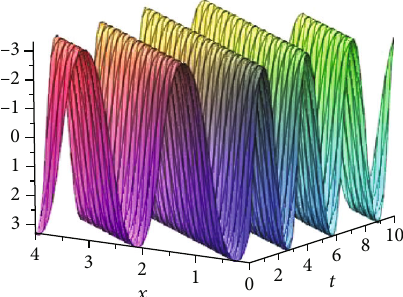
Figure 4: 3D plot of solution (21) of PDE (1).